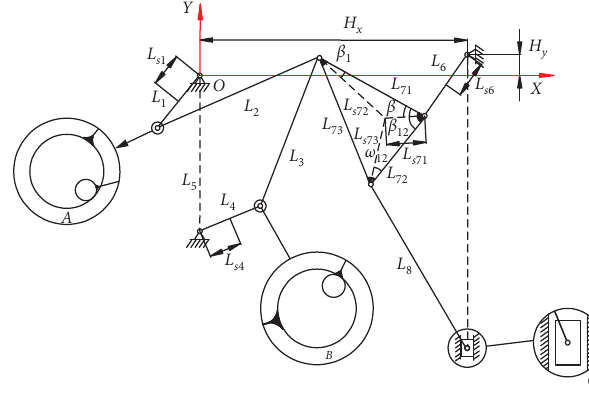
Figure 6: Geometry of 2-DOF nine-bar mechanism considering mixed